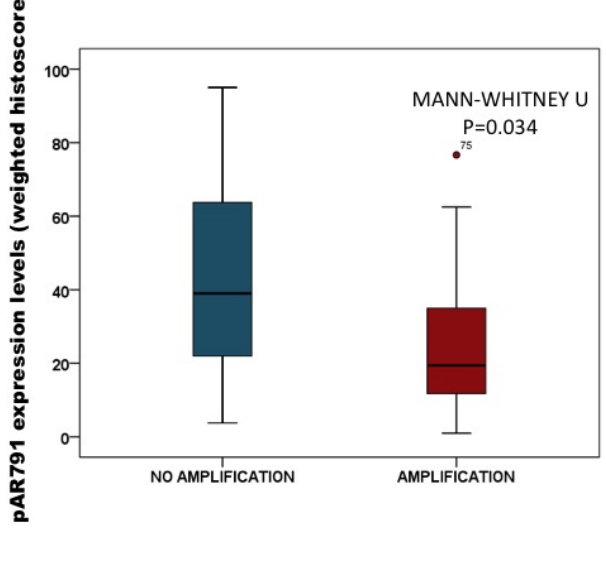
Figure 6. Box plot demonstrates that pAR 791 expression is significantly lower in patients with AR amplification (non amplification 30 patients, amplification 18 patients)